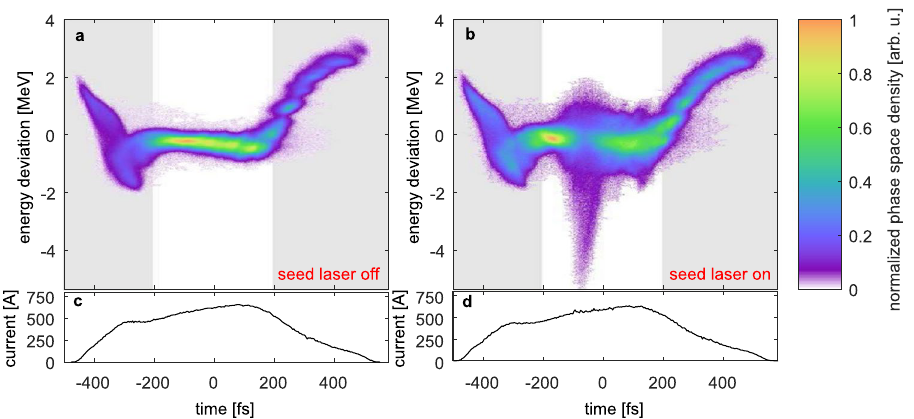
Figure 2. LPSD of an unseeded ( a ) and a seeded electron bunch ( b ) and the corresponding current profiles ( c ) and ( d ). The energy drop and energy spread increase of the electrons due to the FEL process can be seen in the right picture. In the subsequent plots, only the core region (white background) between − 200 fs and + 200 fs that supports FEL lasing will be